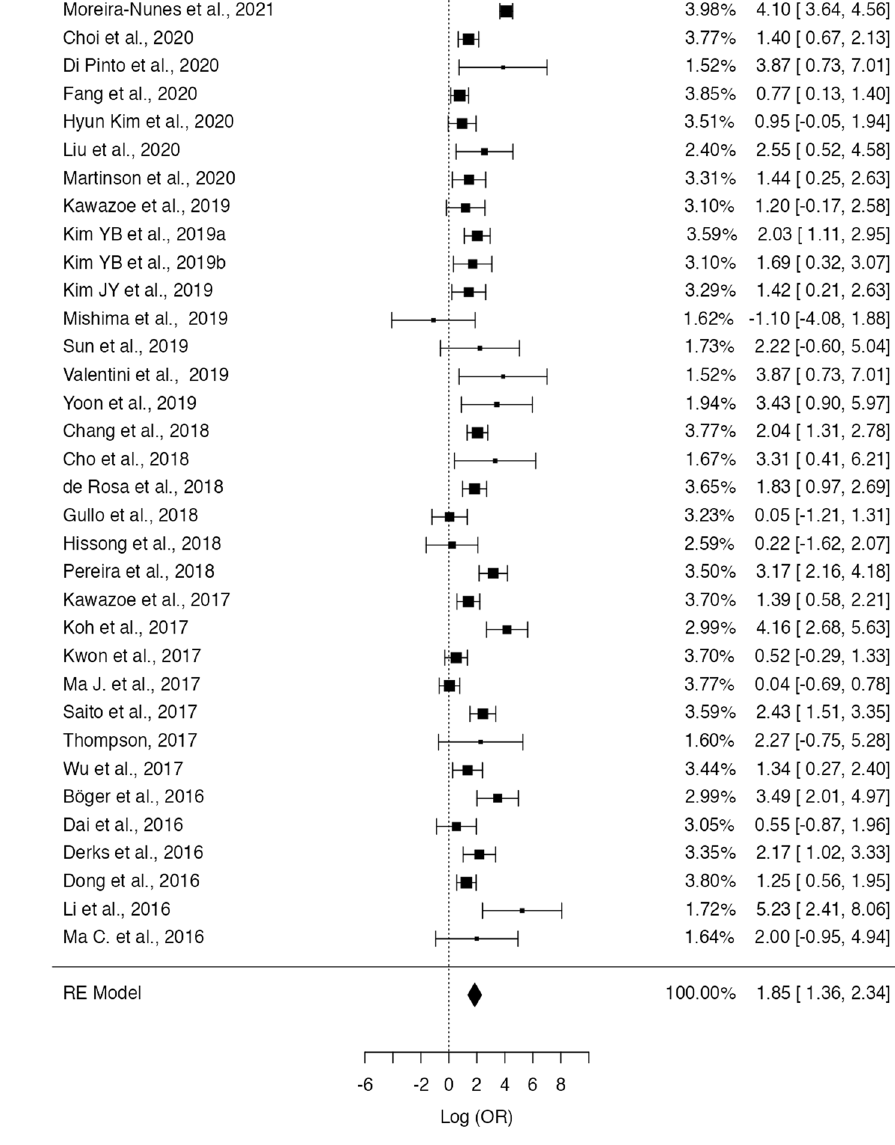
Fig. 2 Forest-plot describing the association between EVB and PD-L1 expression. Loga- rithm for OR is represented in the